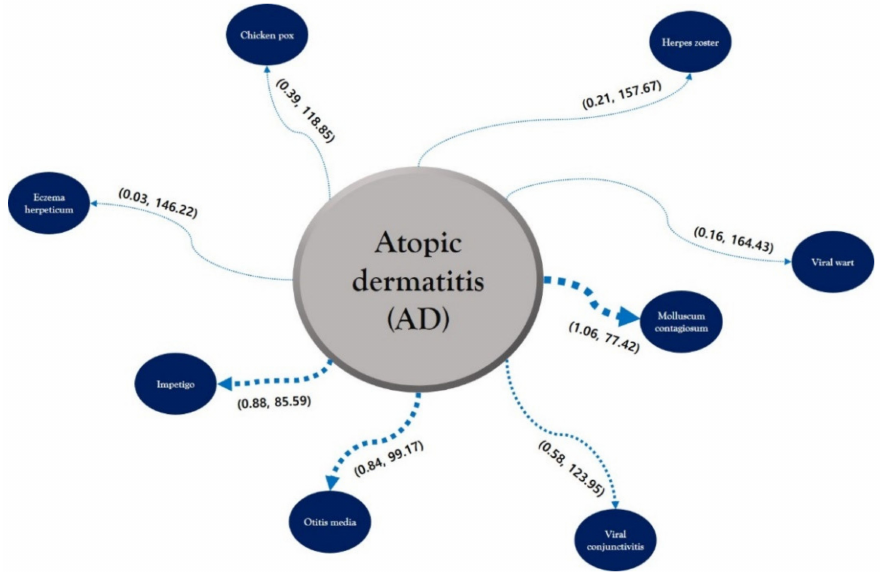
Figure 1. Probability of confidence (%) and time to onset (days) for the sequence patterns between atopic dermatitis and cutaneous infectious disorders. The first number in parentheses indicates the probability of confidence (%), and the second number in parentheses indicates the time to onset